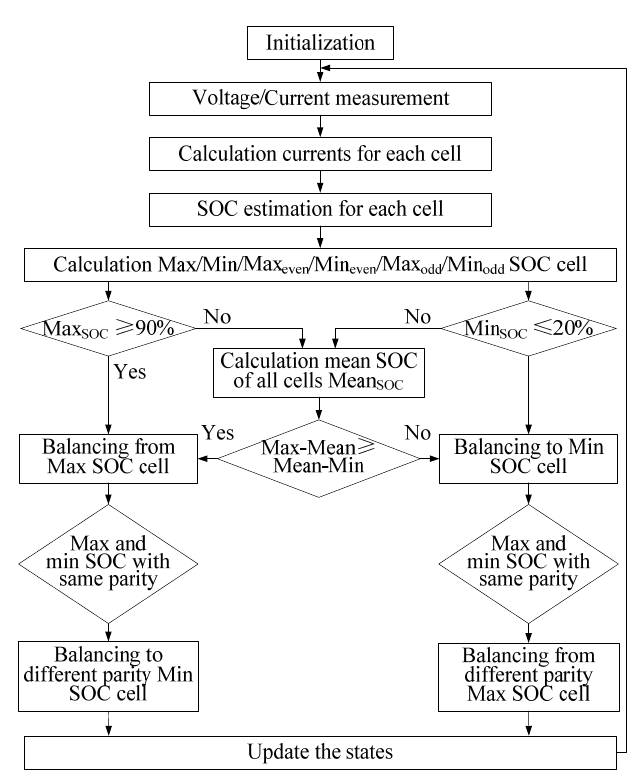
Figure 5. Flowchart of SOC-based balancing